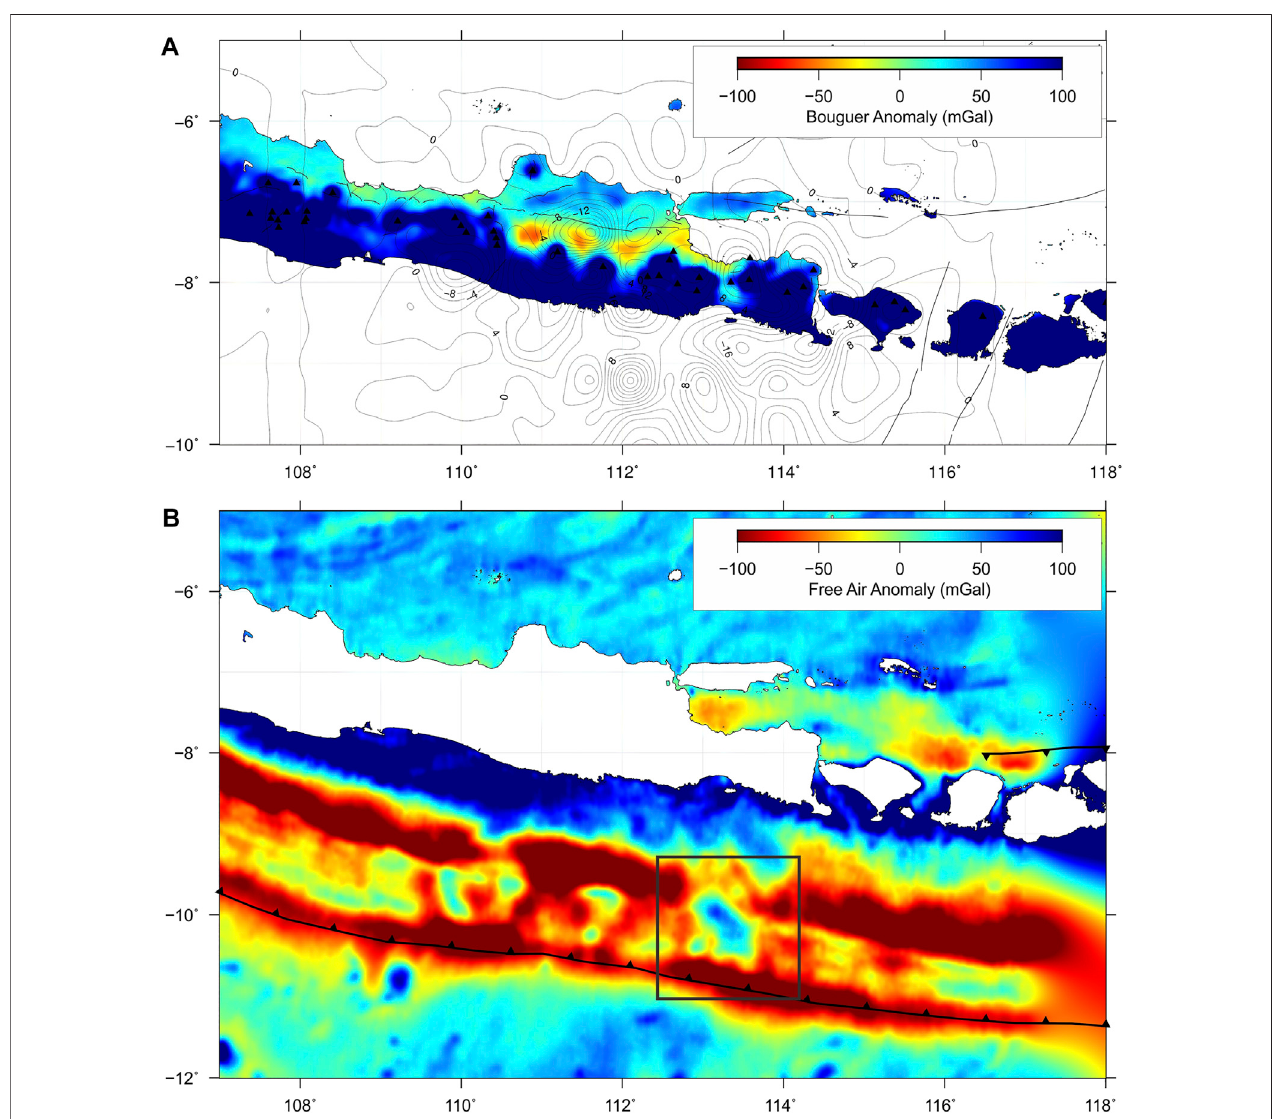
FIGURE 6 | (A) Map of Bouguer gravity anomaly Center for Geological Survey (PSG) overlayed by Vp perturbation at 10 km depth (black contour) and (B) marine free-air gravity anomaly (Sandwell et al., 2014) in Central and East Java region. Black lines indicate faults and trench delineation. Black triangles are the volcanoes. Inset shows the location of subducted